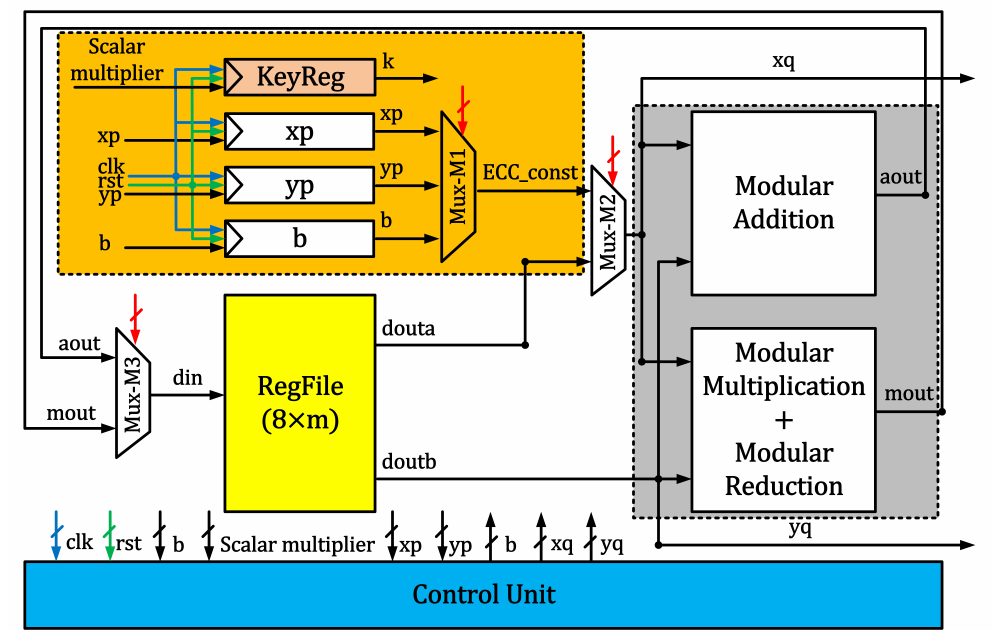
Figure 1. Block diagram of our large field-size elliptic curve cryptographic processor in GF ( 2 m ) .